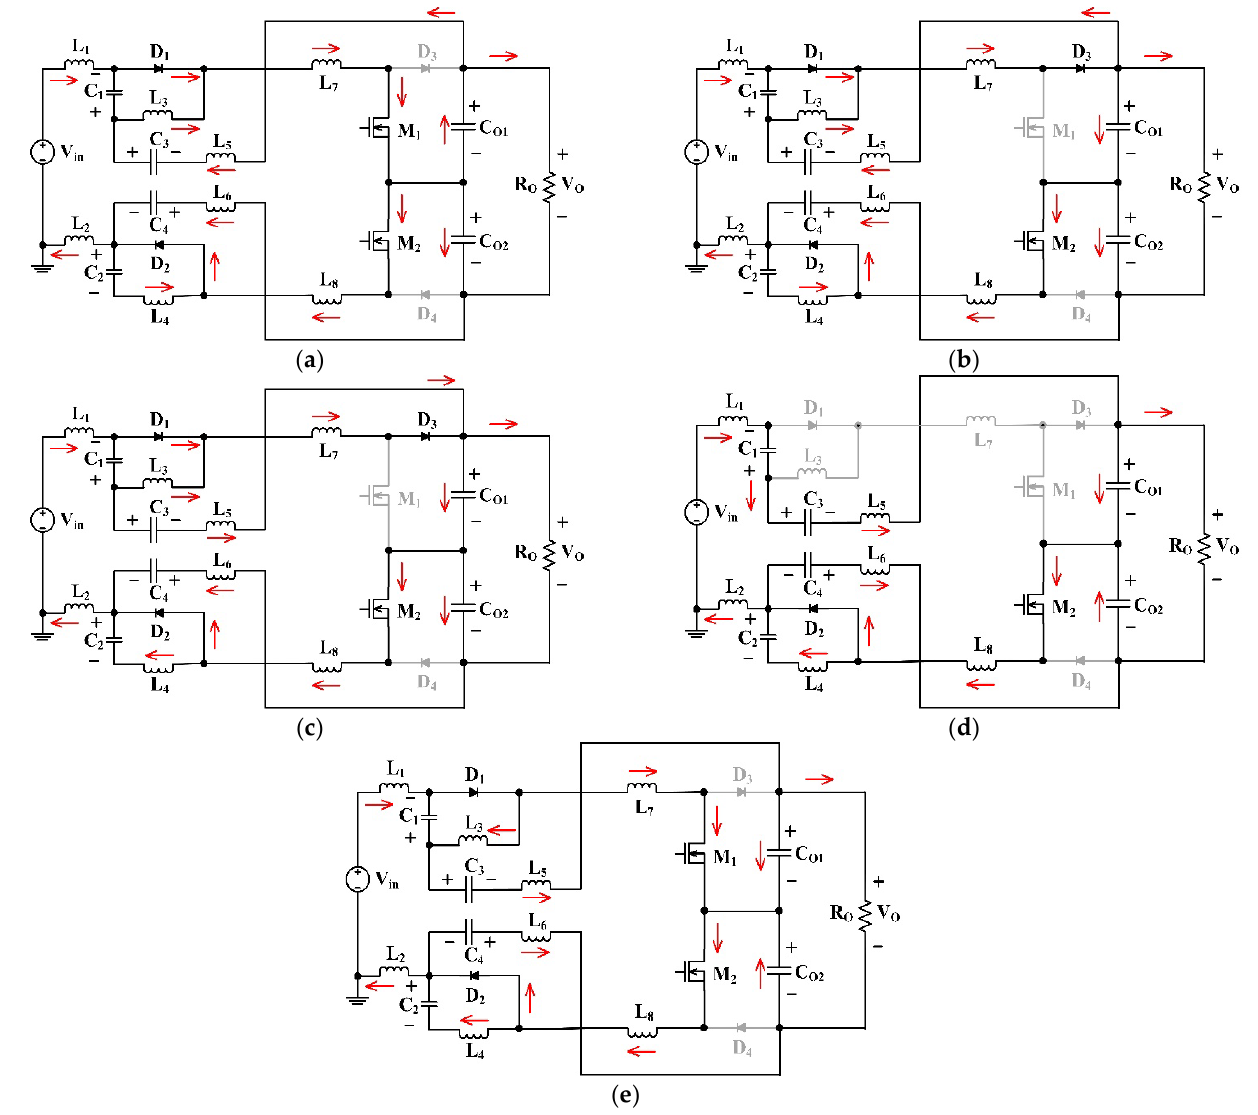
Figure 4. Equivalent circuit for the proposed converter during ( a )—mode 1, ( b )—mode 2, ( c )—mode 3, ( d )—mode 4, and ( e )—mode 5.